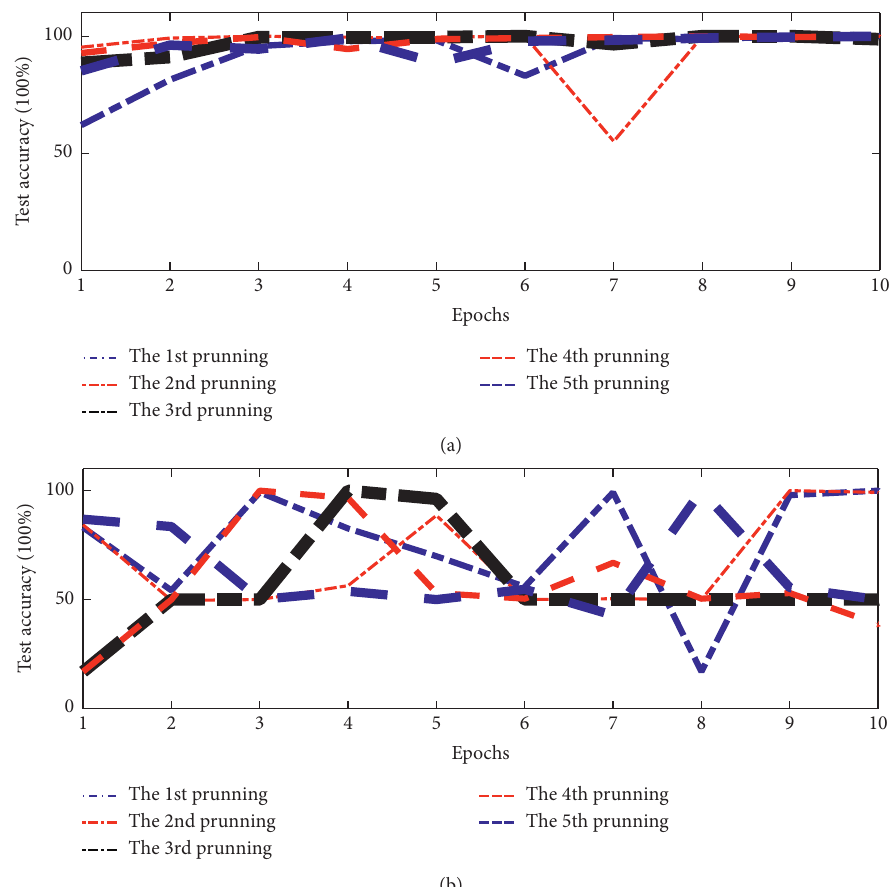
Figure 13: Effect of learning rate on accuracy: (a) LR � 0.00001; (b) LR �